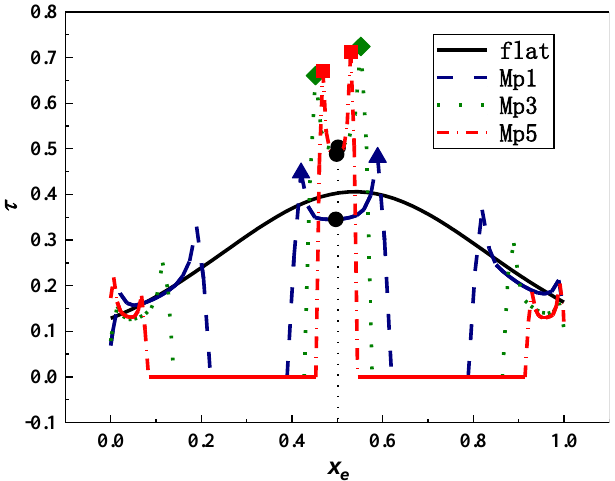
Figure 10. Shear stress downstream distribution. The triangle, diamond, and square correspondingly represent the maximum shear stress point of the Mp1, Mp3, and Mp5. The circle indicates the minimum value shear stress point of the micropit.